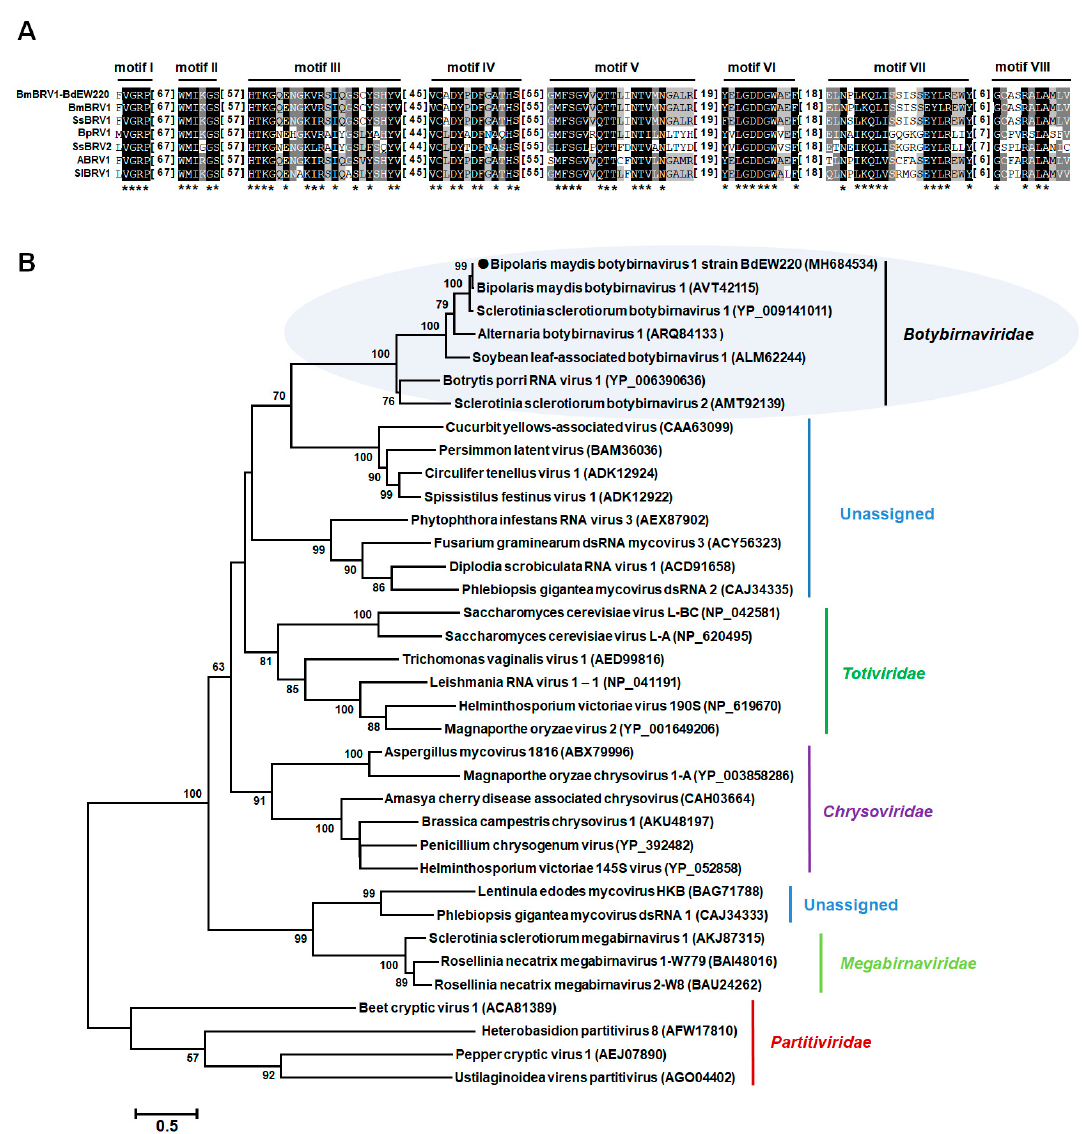
Figure 4. Multiple alignments of the amino acid sequences of the RNA-dependent RNA polymerase of BmBRV1-EW220 with other selected members in Botybirnavirus ( A ) and phylogenetic analysis of BmBRV1-EW220 ( B ). The phylogenetic trees were constructed based on the best-fit model of protein evolution (LG + G + I + F). The gamma value was 2. Bootstrap values (relative) generated using 1000 replicates are shown on the branches. Only bootstrap values of ≥ 50% are presented, and the branch lengths are proportional to the genetic distances. The black circle represents BmBRV1-EW220. Abbreviations used in Figure 4A: BmBRV1-EW220, Bipolaris maydis botybirnavirus 1 strain BdEW220; BmBRV1, Bipolaris maydis botybirnavirus 1; SsBRV1, Sclerotinia sclerotiorum botybirnavirus 1;